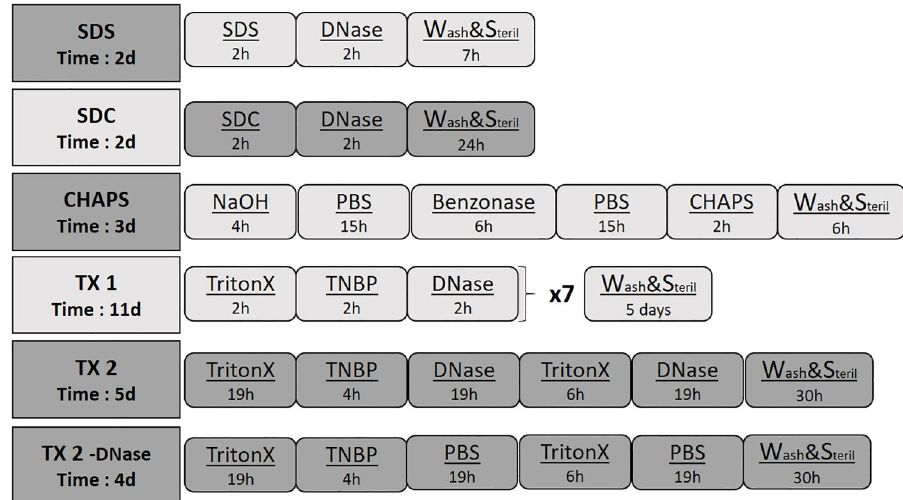
Fig 1. Schematic illustration of decellularization protocols. Concentration of reagents was SDS 0.1%, SDC 1%, NaOH 0.1M, CHAPS 8mM, TritonX 1%, TNBP 1%, DNase 40 U/mL and Benzonase 2 U/mL. Underneath the abbreviation for each protocol, the total process time for a single vein decellularization is noted. The group TX 2 is a novel, shorter TX-based protocol, and the group TX 2 -DNase was treated as the TX 2 group, but without enzyme